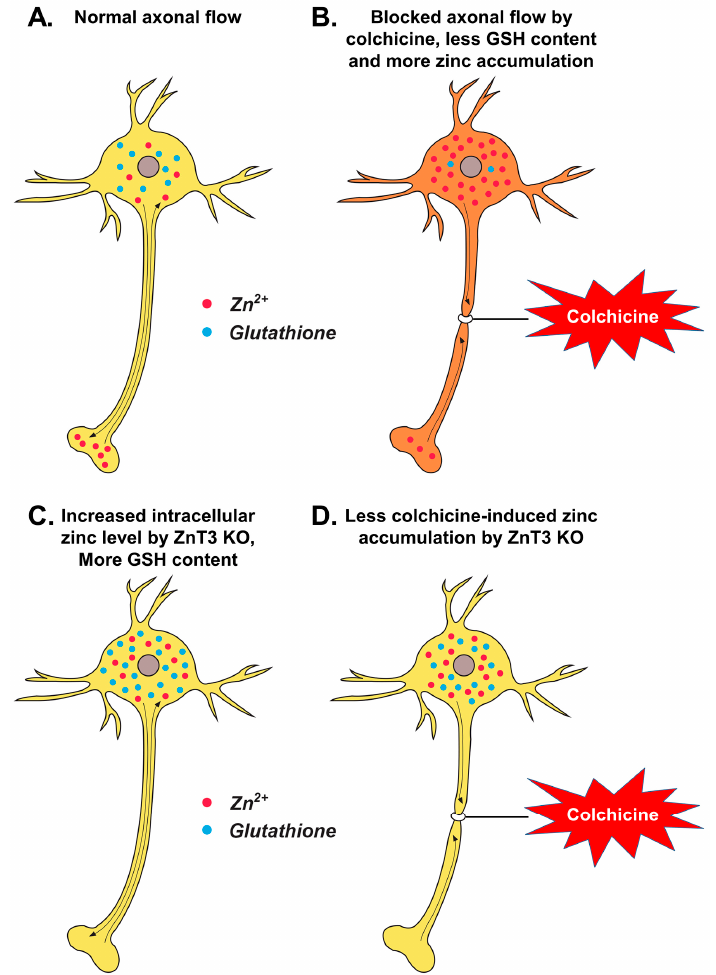
Figure 5. Proposed mechanism by which ZnT3 knockout reduces colchicine-induced dentate granule cell degeneration. This schematic drawing indicates several chain reactions that are thought to occur after colchicine injection in ZnT3 − / − mice. ( A ) Cytoplasmic and vesicular zinc are normally moved by the axonal flow in WT mice. Zinc transport is essential for axonal flow in neurons. In addition, the concentration of GSH is much greater in the neuronal cytoplasm; ( B ) Blocked axonal flow by colchicine induces depletion of GSH content and an increase of intracellular zinc accumulation, thereby causing neuronal death; ( C ) ZnT3 gene deletion causes an increased intracellular free zinc level and increased neuronal GSH levels; ( D ) Genetic deletion of ZnT3 attenuates colchicine-induced zinc accumulation and dentate granule cell